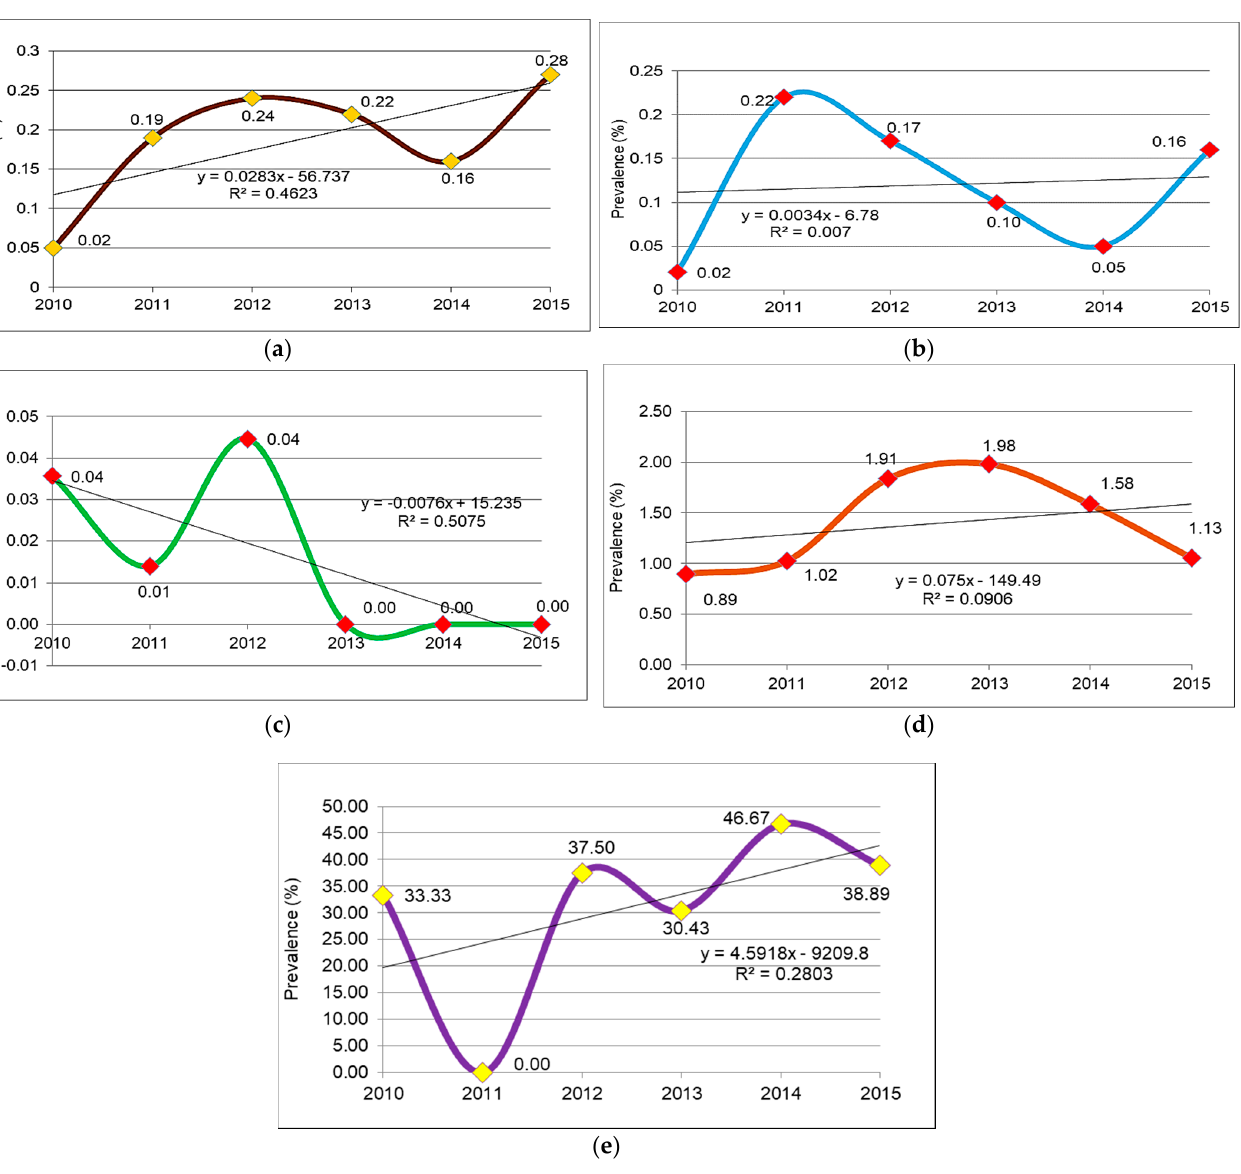
Figure 1. ( a ) Dynamics of the general prevalence (%) of Trichinella infection in animals in Northeastern Romania (2010–2015); ( b ) Specific dynamics of Trichinella infection in pigs (2010–2015); ( c ) Specific dynamics of Trichinella infection in horses (2010–2015); ( d ) Specific dynamics of Trichinella infection in wild boar (2010–2015); ( e ) Specific dynamics of Trichinella infection in bears (2010–2015).